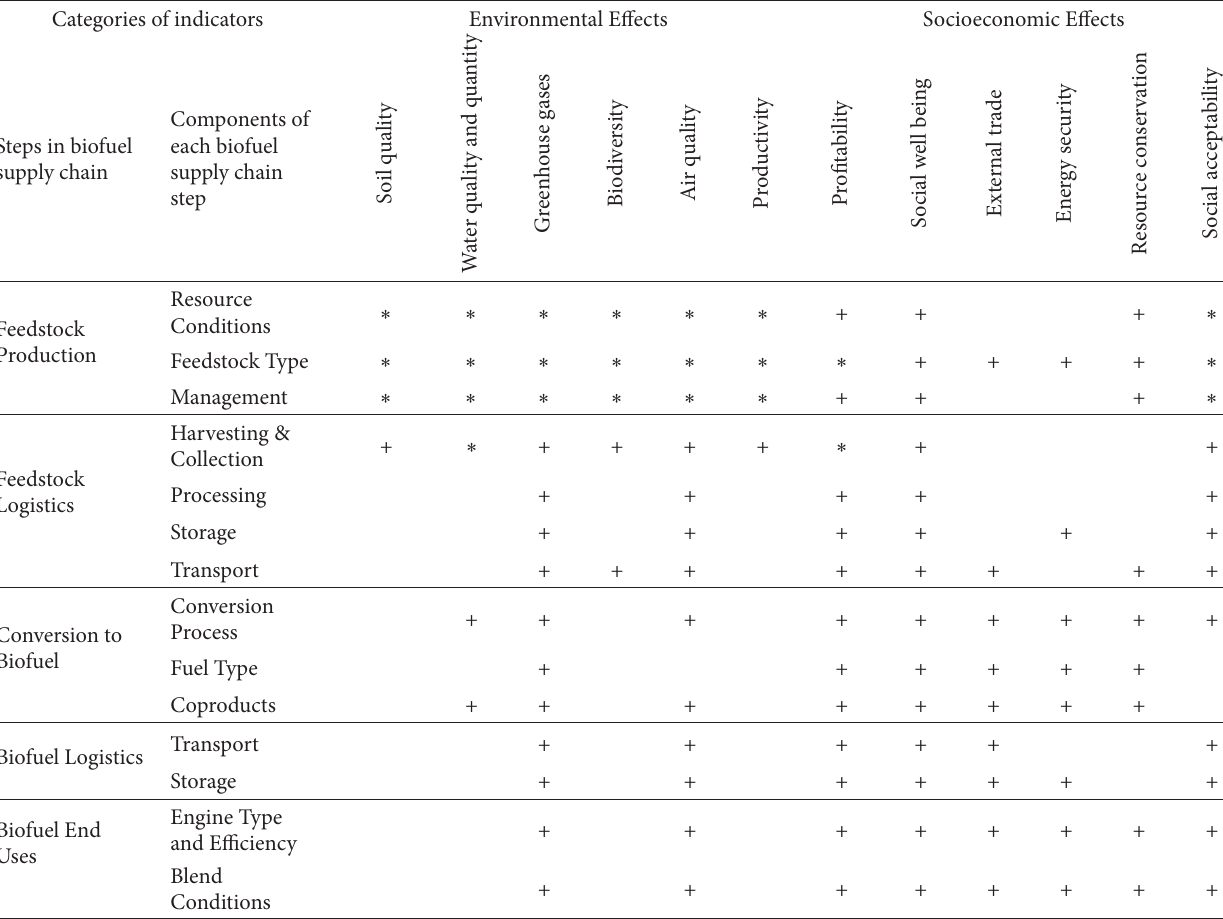
, and additional effects exhibited by all ∗